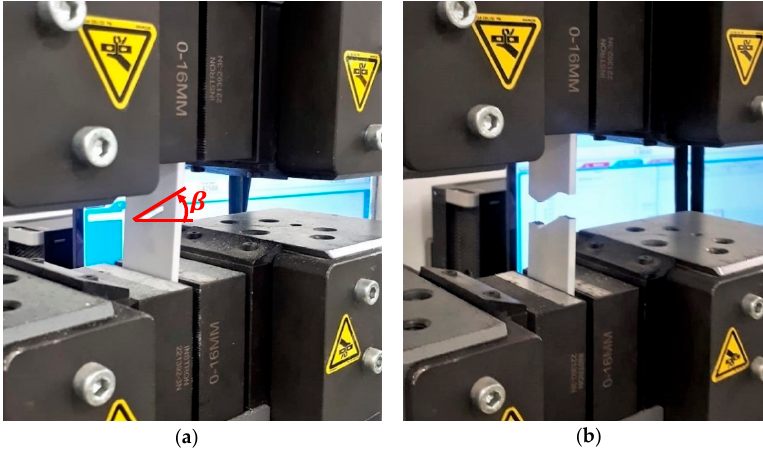
Figure 4. An MJF nylon 3D-printed specimen under tensile test conditions; ( a ) before ( b ) after fracture. Table 2. The experimental failure loads of the examined 3D-printed specimens.